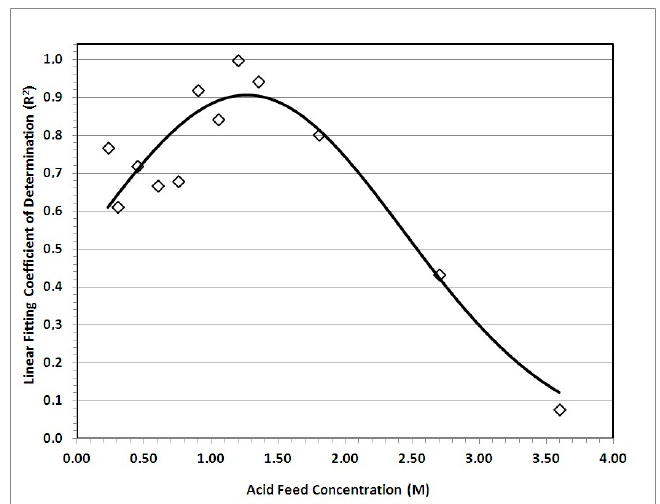
Figure 2. Variation of the linear fitting coefficient of determination ( R 2 ) of linearized 1st order kinetics with acid feed concentration ( C Af ), for the Sc leaching kinetics experiments of Figure 1 (BR leaching with sulfuric acid solution, at L/S = 50). Solid line: Optimized fitting of a general Gaussian function, G(C Af ) = a × exp( − b(C Af − μ ) 2 ) , where a = 0.905 , b = 0.3673 Μ − 2 , and μ = 1.267 Μ .